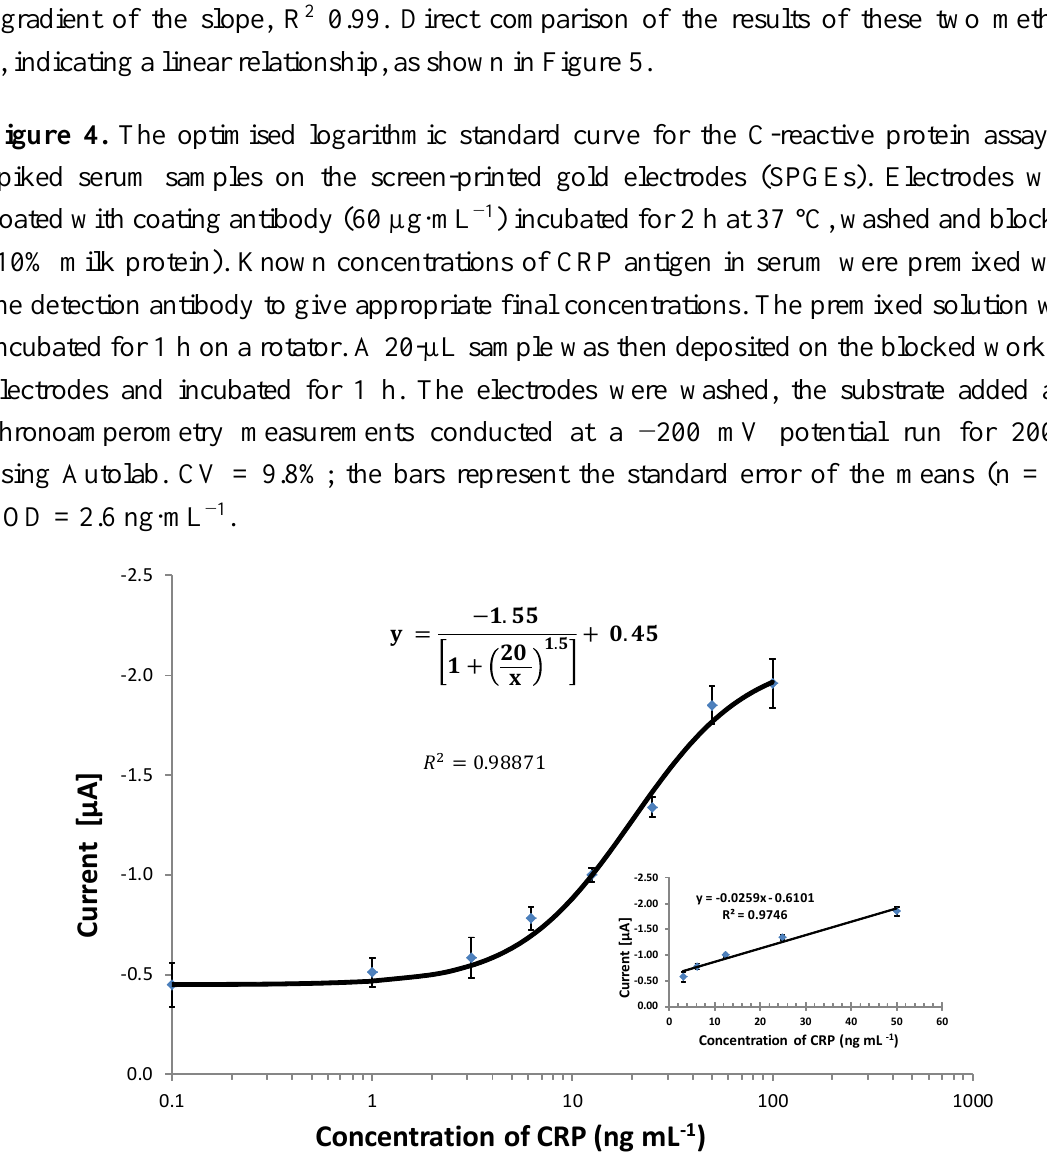
Figure 5. The correlation of the developed immunosensor and the commercial ELISA assay using the same randomly spiked serum samples analysed using both